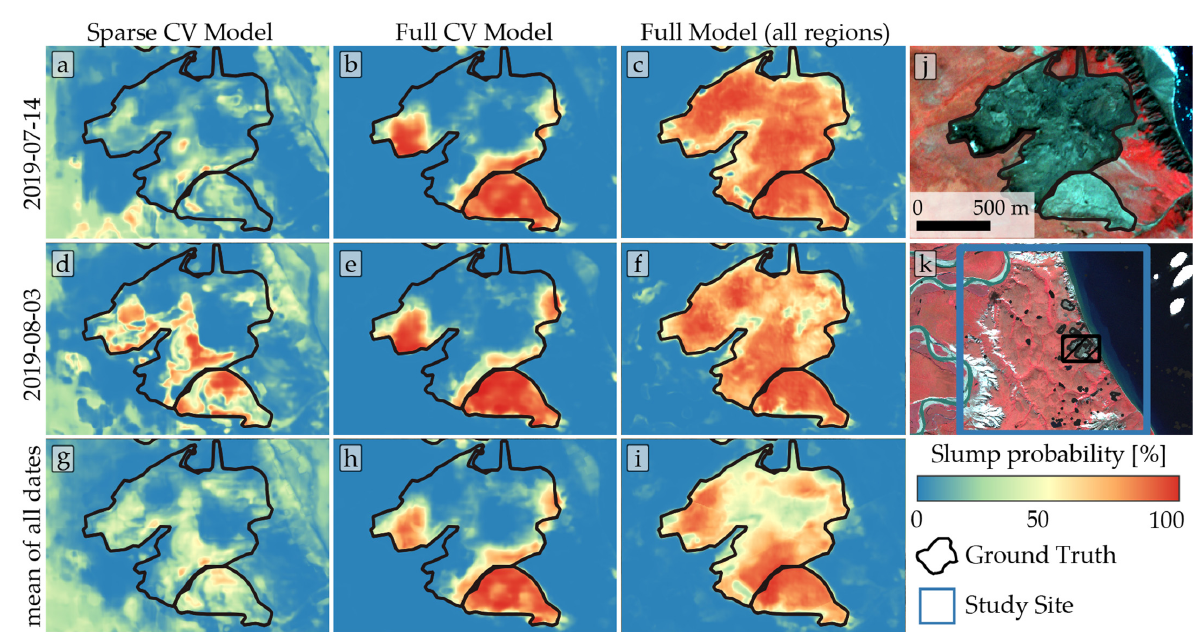
Figure 6. Detection results in subset of Horton Delta 01 study site with the modeled RTS probability on two different image dates (( a – c ): 14 July 2019; ( d – f ): 03 August 2019) and the mean of all dates ( g – i ) as well as three different models (( a , d , g ): sparse cross-validation model; ( b , e , h ): full cross-validation model; ( c , f , i ): full model trained on all regions). The subset of a multispectral false-color PlanetScope image (NIR-R-G) with ground truth is shown in panel ( j ). Panel ( k ) shows the approximate location of the subset within the study region.